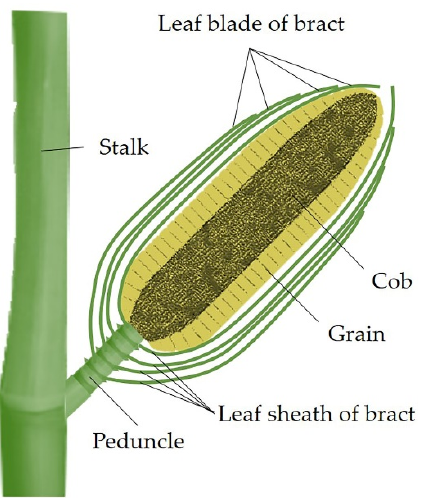
Figure 2. Section diagram of morphological structure of a corn ear.